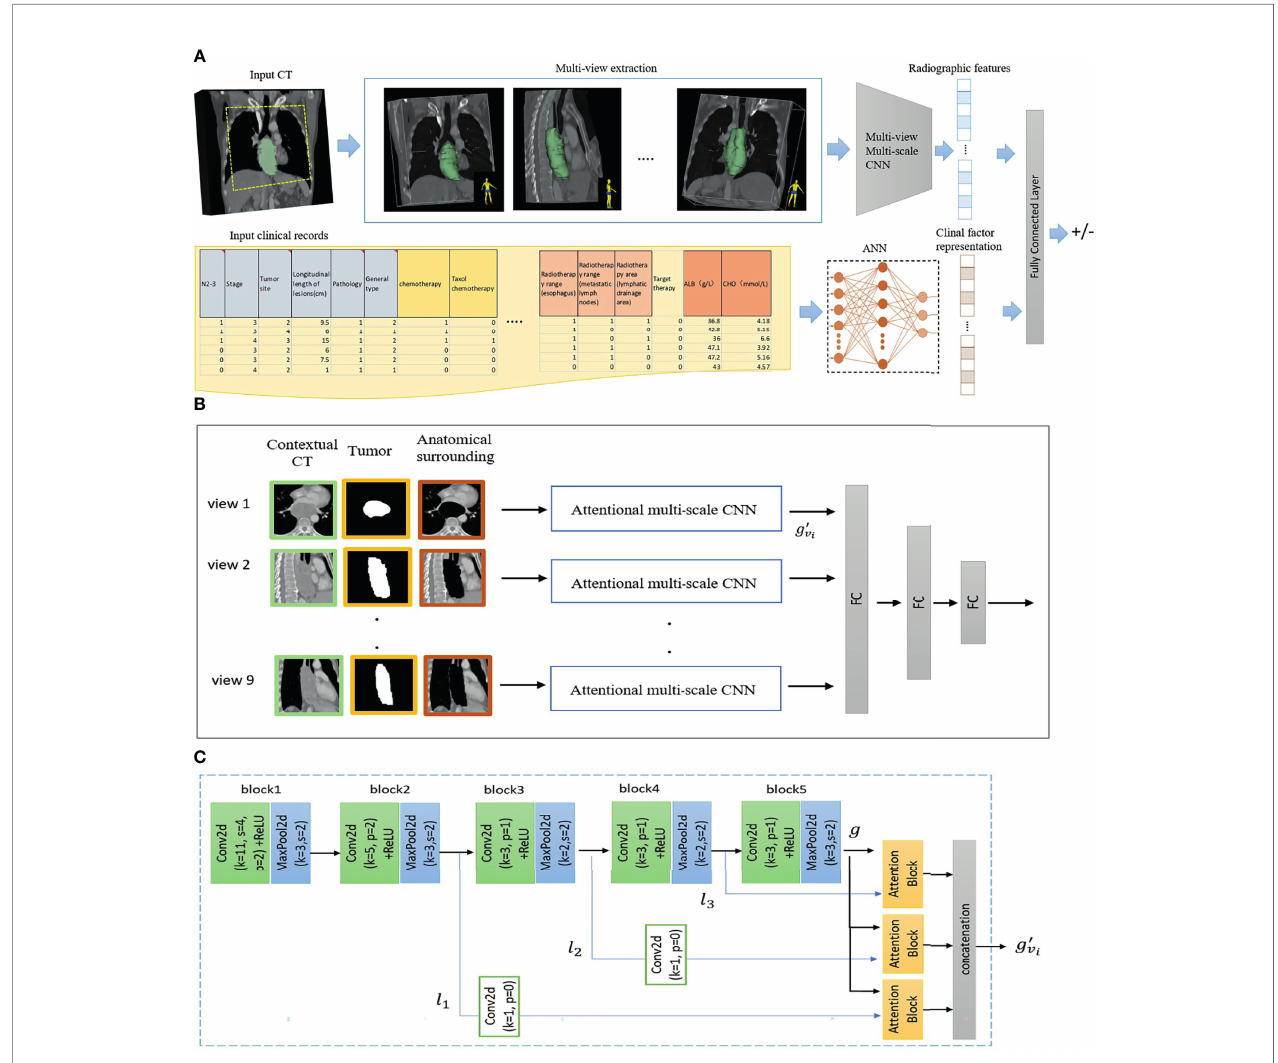
FIGURE 3 | The proposed risk prediction model (A) Given an input CT and segmented tumor, 9 views of planes are extracted. Contextual CT, tumor and anatomical surrounding patches of each view are sent to a Multi-view Multi-scale CNN model for radiographic feature extraction. For the input clinical records, an arti fi cial neural network (ANN) is used to extract clinical factor representations. Finally, radiographic and clinical features are fused by a fully connected layer for esophageal fi stula prediction. Architecture of Multi-view Multi-scale CNN is given in (B) . Contextual CT, tumor and anatomical surrounding patches extracted from each view are sent to (C) attentional multi-scale CNN. Multi-scale features are extracted from the second, third and fourth blocks in the CNN, and adaptively fused by attention